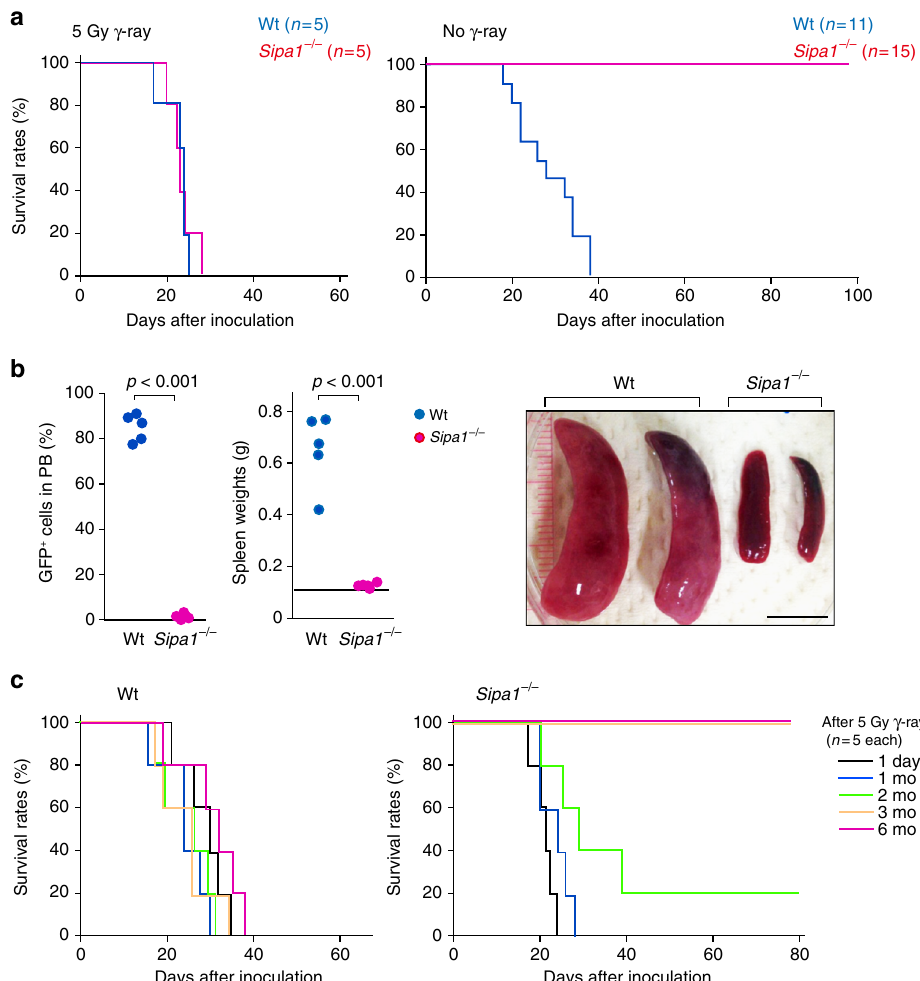
Fig. 1 Bcr-Abl + HPCs fail to develop CML in unirradiated Sipa1 − / − mice. a Normal Lin − BM cells (HPCs) from Wt B6 mice were infected with retrovirus containing p210Bcr-Abl and intravenously injected into Wt B6 and Sipa1 − / − B6 mice at 1.5 × 10 4 cells per mouse with or without prior γ -ray irradiation. Survival curves of the indicated numbers of mice per group are shown. Independent experiments were performed for two times with similar results. b On day 20 after injection of Bcr-Abl + HPCs, the proportions of GFP + cells in the peripheral blood (PB) leukocytes and the weights of spleens were examined. A bar indicates the mean spleen weight of control mice, and p values were determined with two-tailed unpaired Student ’ s t -test. Representative pictures of spleens are also shown. Scale bar, 10 mm. c Wt and Sipa1 − / − mice were intravenously injected with Bcr-Abl + HPCs at varying intervals after irradiation with 5 Gy γ -ray. Survival curves of fi ve mice per group are shown. Independent experiments were done twice with similar